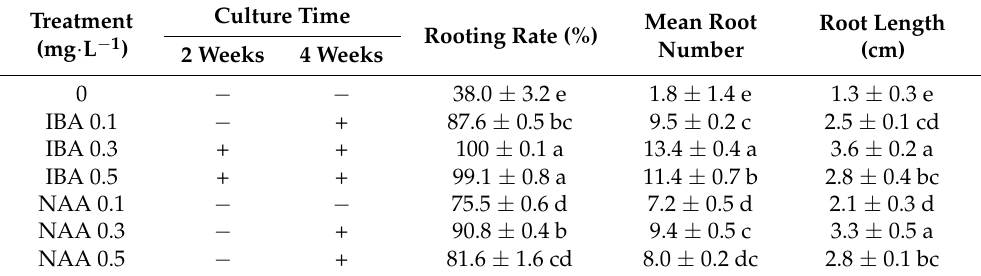
Table 4. Effects of auxins on root induction of Sinningia hybrida ‘Isa’s Murmur‘. Treatment